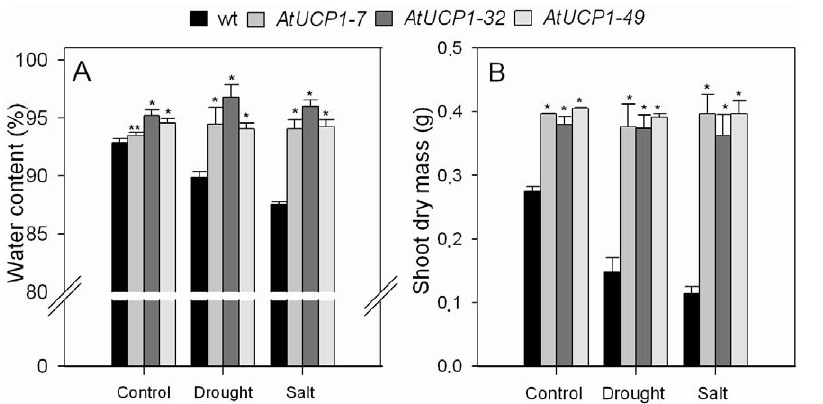
Figure 3. Water content (A) and shoot dry mass (B) in stressed leaves of wild-type (WT) and AtUCP1 transgenic plants (7, 32 and 49). Thirty-day-old plants were exposed for 10 days to 200 mM mannitol or 175 mM NaCl and then recovered with pure water for 3 days. In the controls, plants were irrigated with water. The bar represents the mean, and I represents the standard deviation from three independent experiments (n=5). * and ** indicate significant differences relative to the control at P , 0.0001 and P , 0.001,